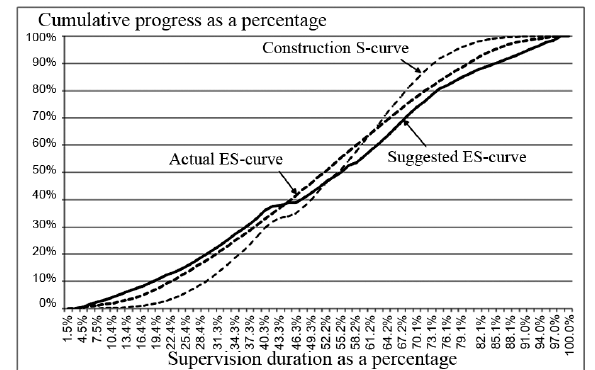
Fig. 6. Actual and suggested ES-curves of the test project during the control